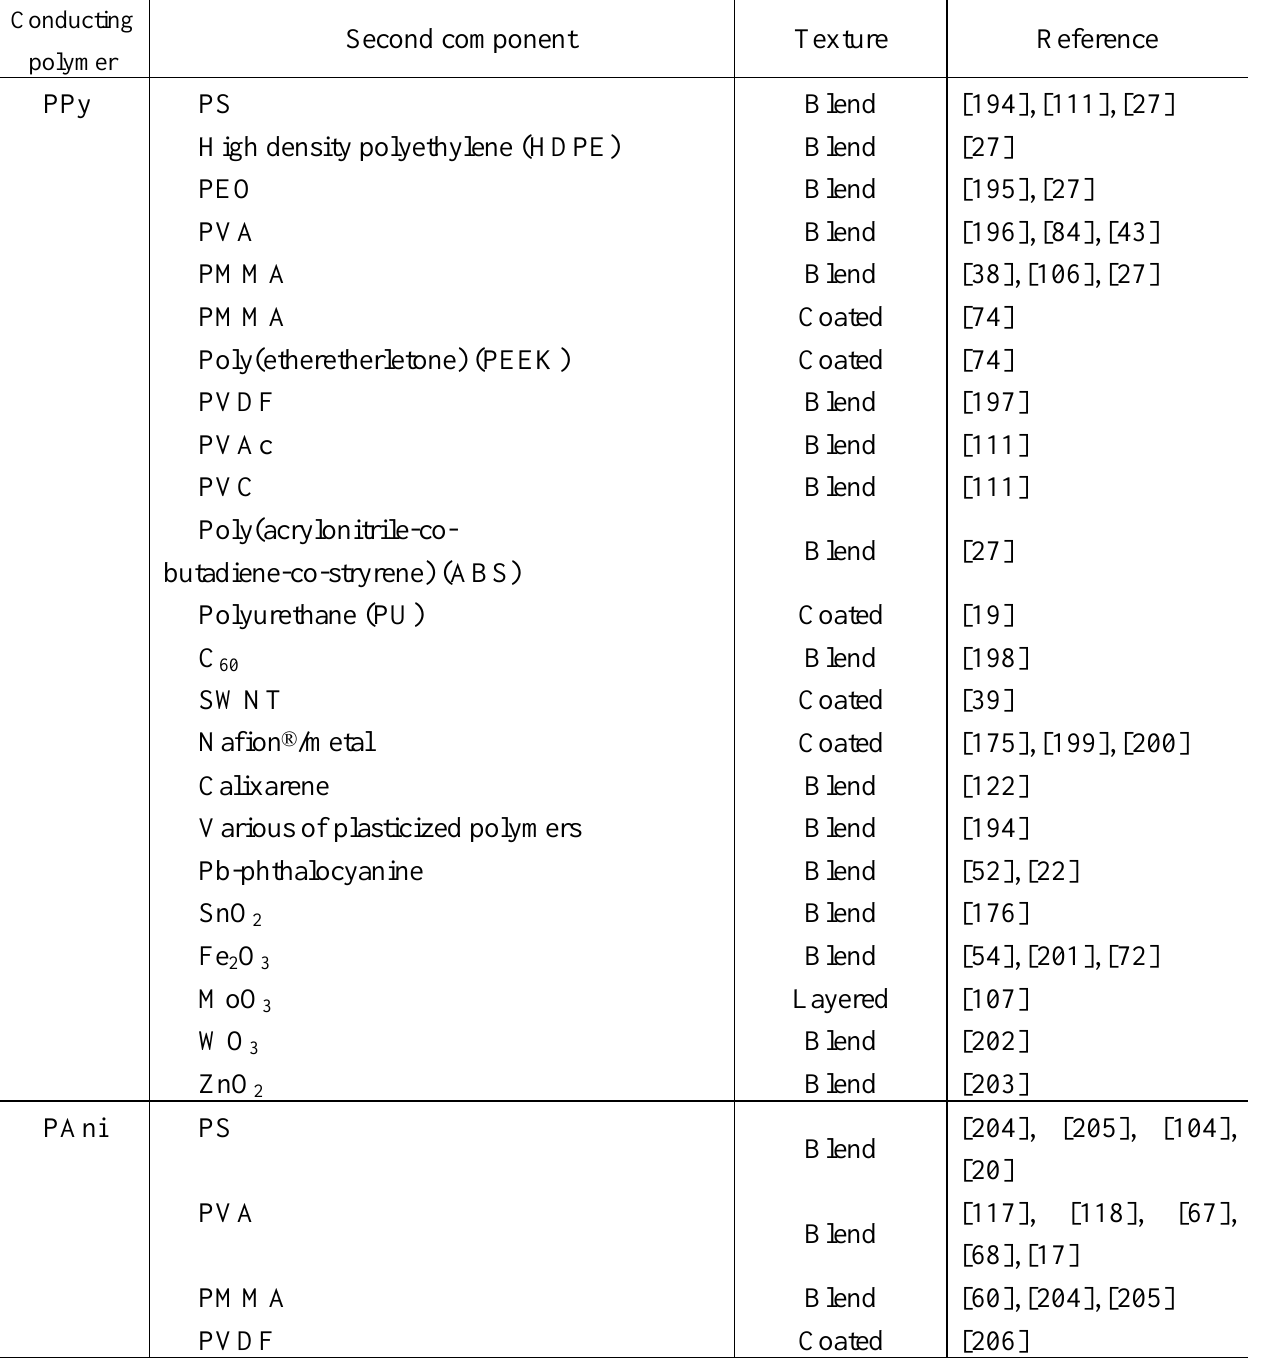
Table 2. Conducting polymer composite used in gas